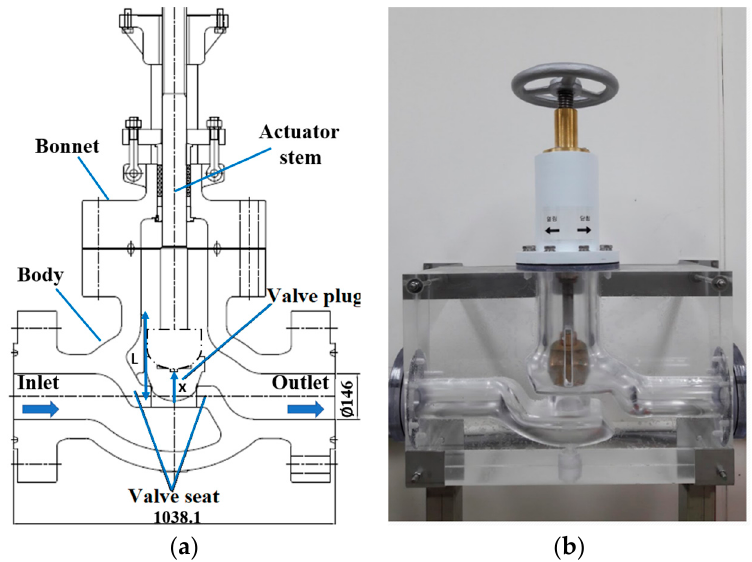
Figure 3. Prototype and model of the test valve: ( a ) eight-inch ANSI B16.11—Class 2500# globe valve; ( b ) three-inch model globe valve.